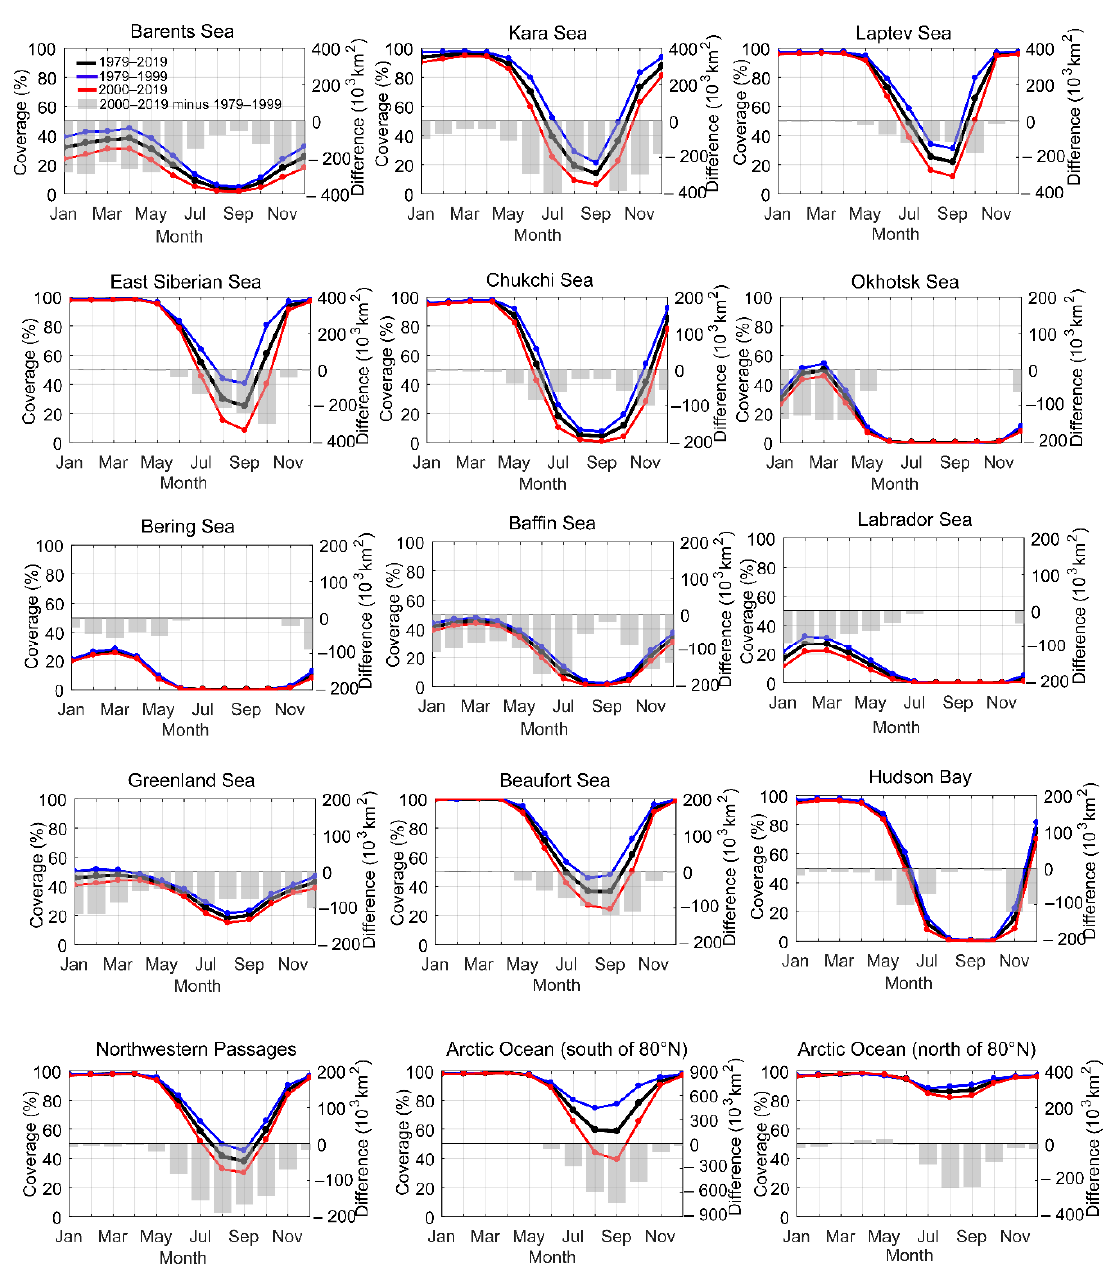
Figure 2. Monthly sea ice coverage (% of the selected sea/region area) for individual seas in three periods: 1979–2019 (black curve), 1979–1999 (blue curve) and 2000–2019 (red curve) and differences between mean SIA in 2000–2019 and 1979–1999 (grey bars).